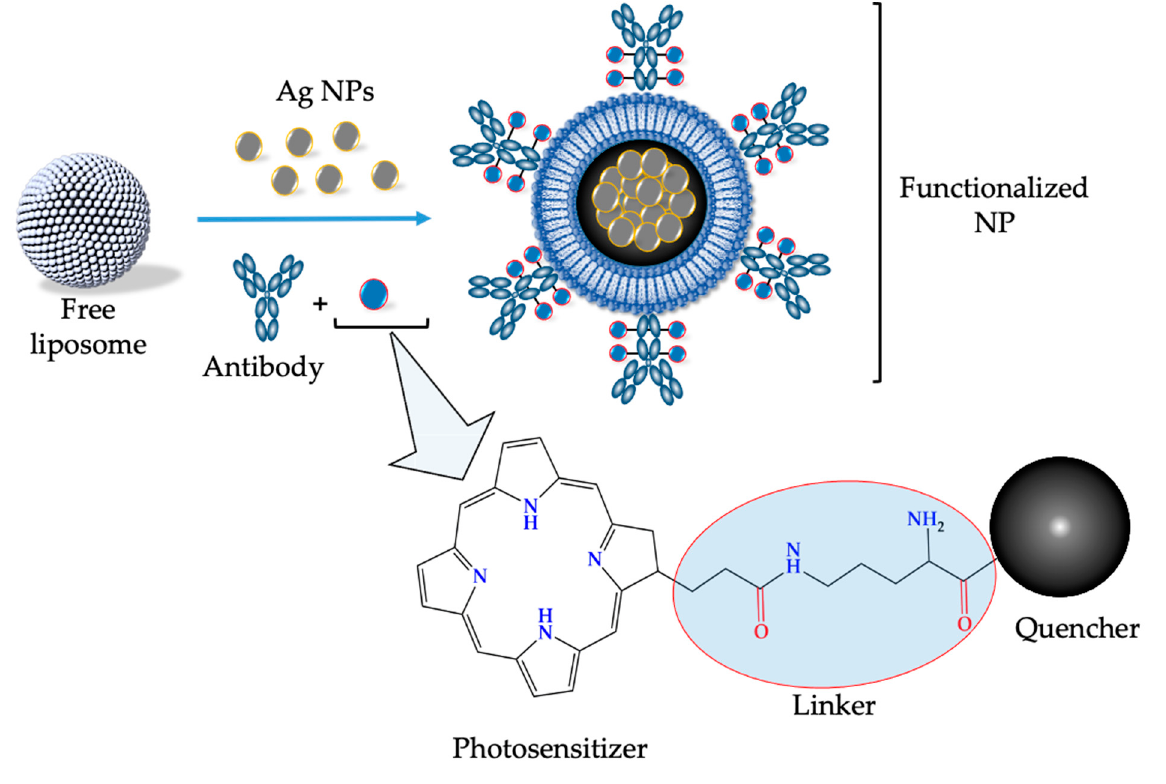
Figure 5. Schematic representation of hybridized liposome encapsulated silver nanoparticles (Ag NPs) functionalized with activatable PS.